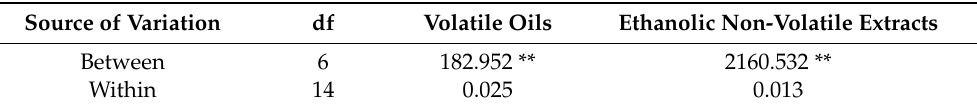
Table 3. Mean squares of analysis of variance for antifungal activity of volatile and non-volatile constituents of M. suaveolens L. Source of Variation df Volatile Oils Ethanolic Non-Volatile Extracts Between 6 182.952 ** 2160.532 ** Within 14 0.025